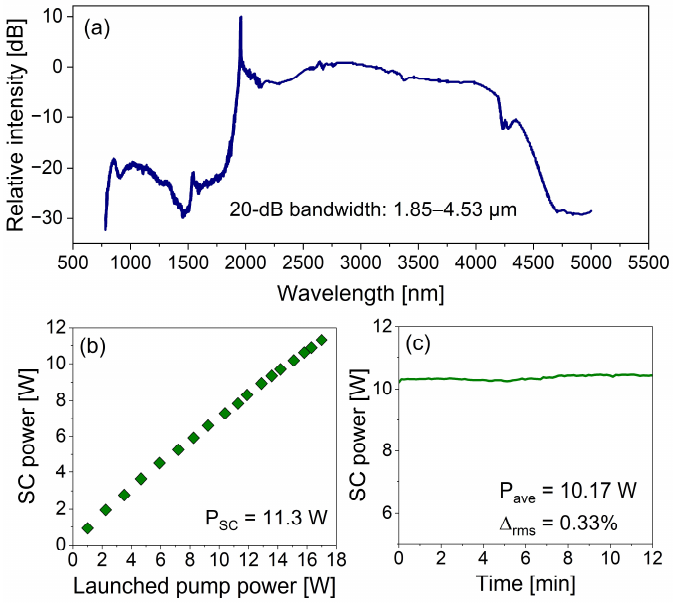
Figure 11. SC spectrum measured for the average output power of 11.3 W ( a ); SC power as a function of launched pump power ( b ); and short-term output power stability ( c ). Δ rms refers to the normalized root mean square. Adopted with permission from [42]. Copyright 2019, Optica Publishing Group.